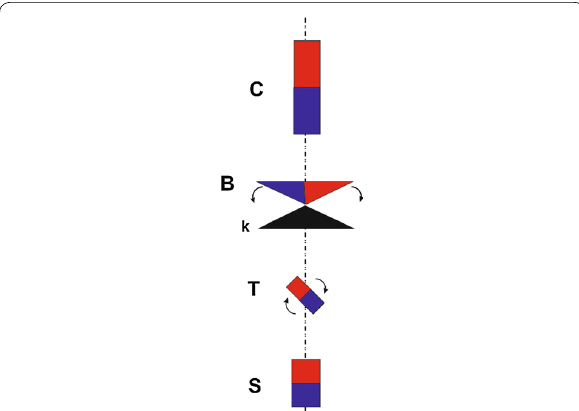
Fig. 9 Diagram of the principle of measurement of vertical intensity Z with BMZ. Three magnets ( S , C , and T ) compensate the natural magnetic field at the position of the horizontal magnet B